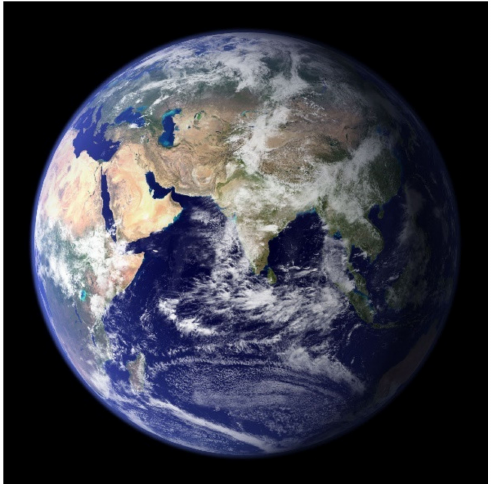
Figure 1. The blue marble, courtesy of Nasa